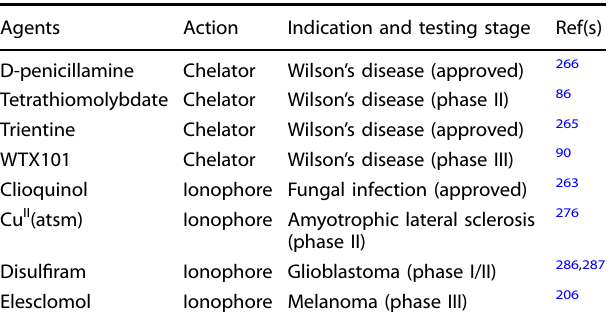
Table 1. Overview of the clinical development of Cu-